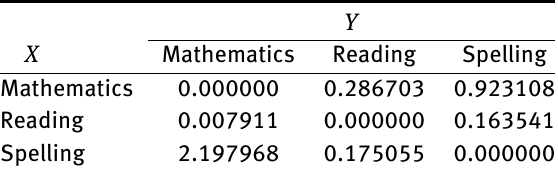
Table 4: Conditional-median based LOC matrix (entries multiplied by 1, 000